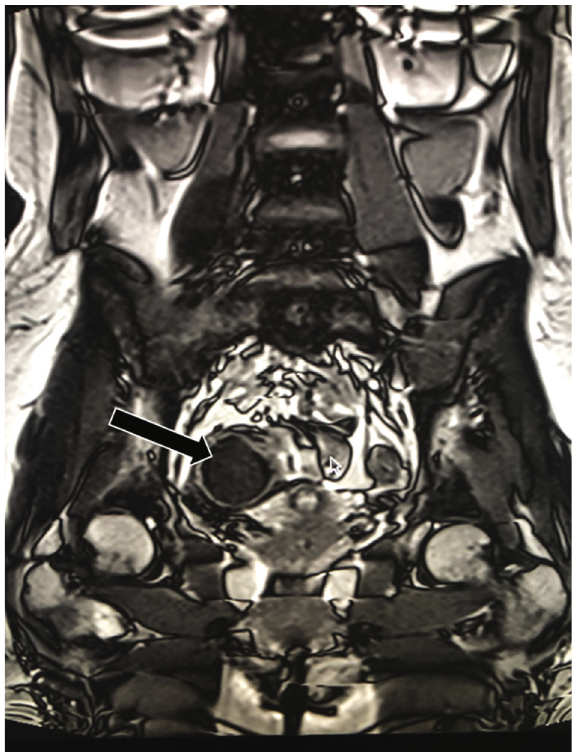
Figure 1: Magnetic resonance imaging showing a cyst at the right iliac